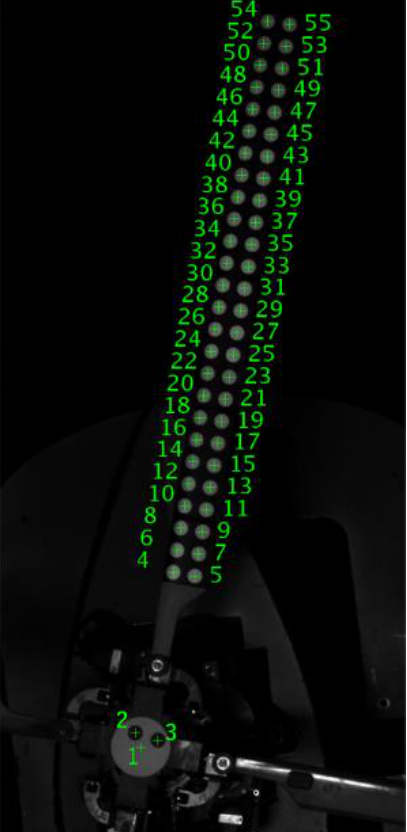
Figure 9. Numbering of all targets on the rotor.